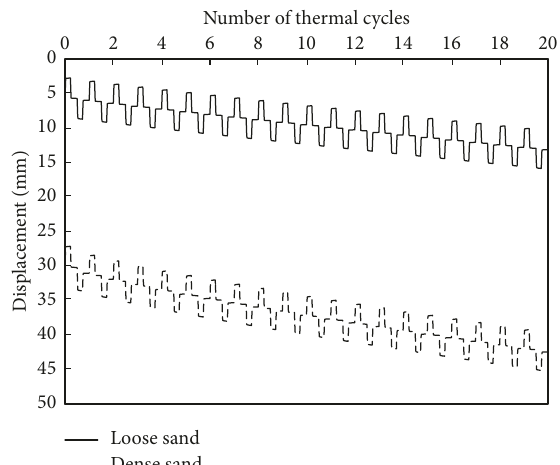
Figure 11: Variations in pile head displacement for the free head pile.